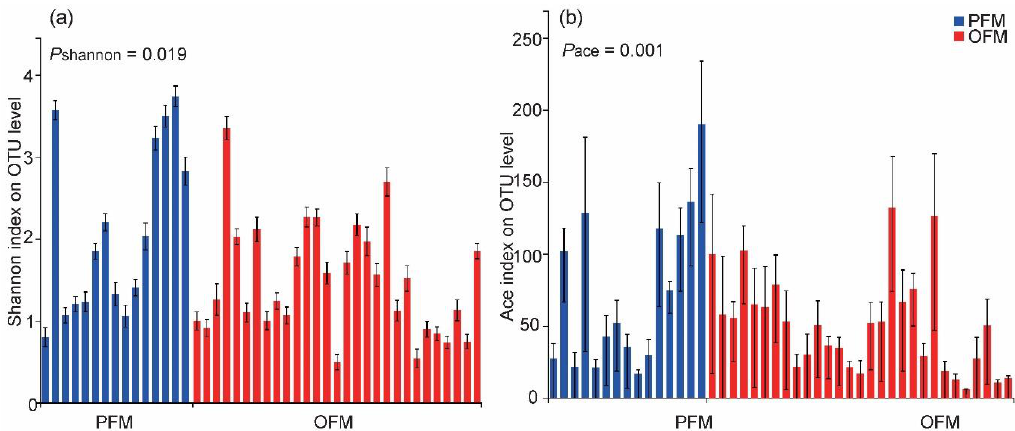
Figure 3. Community diversity ( a ) and richness ( b ) for the OTU level of gut bacterial microbiota between the peach fruit moth (PFM) Carposina sasakii and the oriental fruit moth (OFM) Grapholita molesta . Each bar represents an individual moth. There is significance of the difference between PFM and OFM in diversity and richness in term of Shannon ( a ) and Ace ( b ) index estimated by Kruskal–Wallis test.